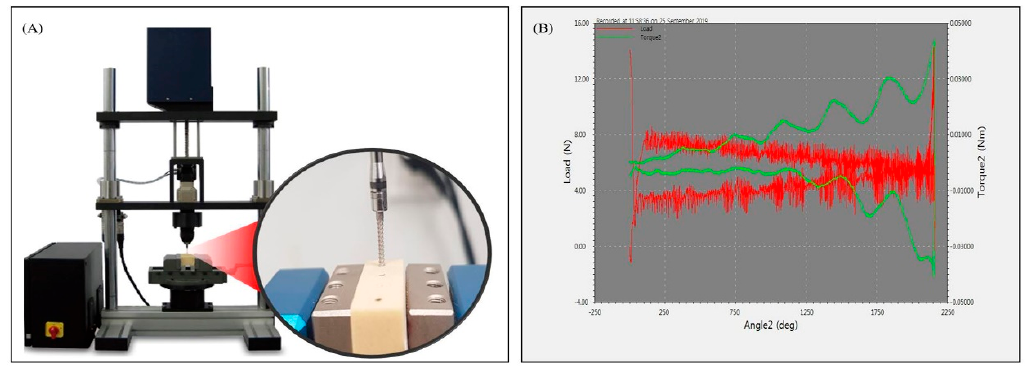
Figure 5. Insertion torque measurement using the automatic torque device. ( A ) automatic torque device ( B ) angle–torque graph.